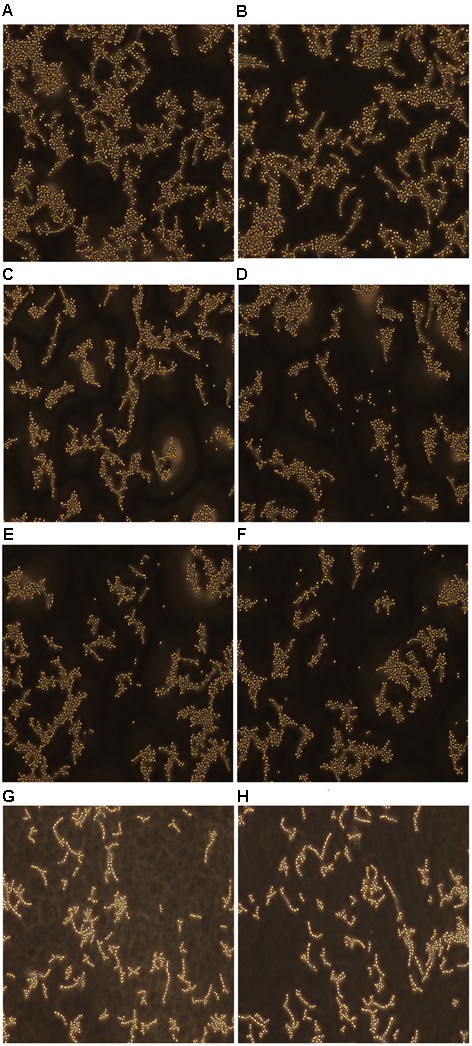
Fluorescence microscope examined the yeast-filament transition of resistant C. albicans (CA10). After 24 h of incubation, C. albicans treated with different drugs as described. (A,B) Untreated controls group; (C,D) fluconazole treated (1 μg/mL) group; (E,F) licofelone treated (16 μg/mL) group; (G,H) the combination of fluconazole (1 μg/mL) and licofelone (16 μg/mL) treated group. The experiment was repeated on 3 independent occasions.